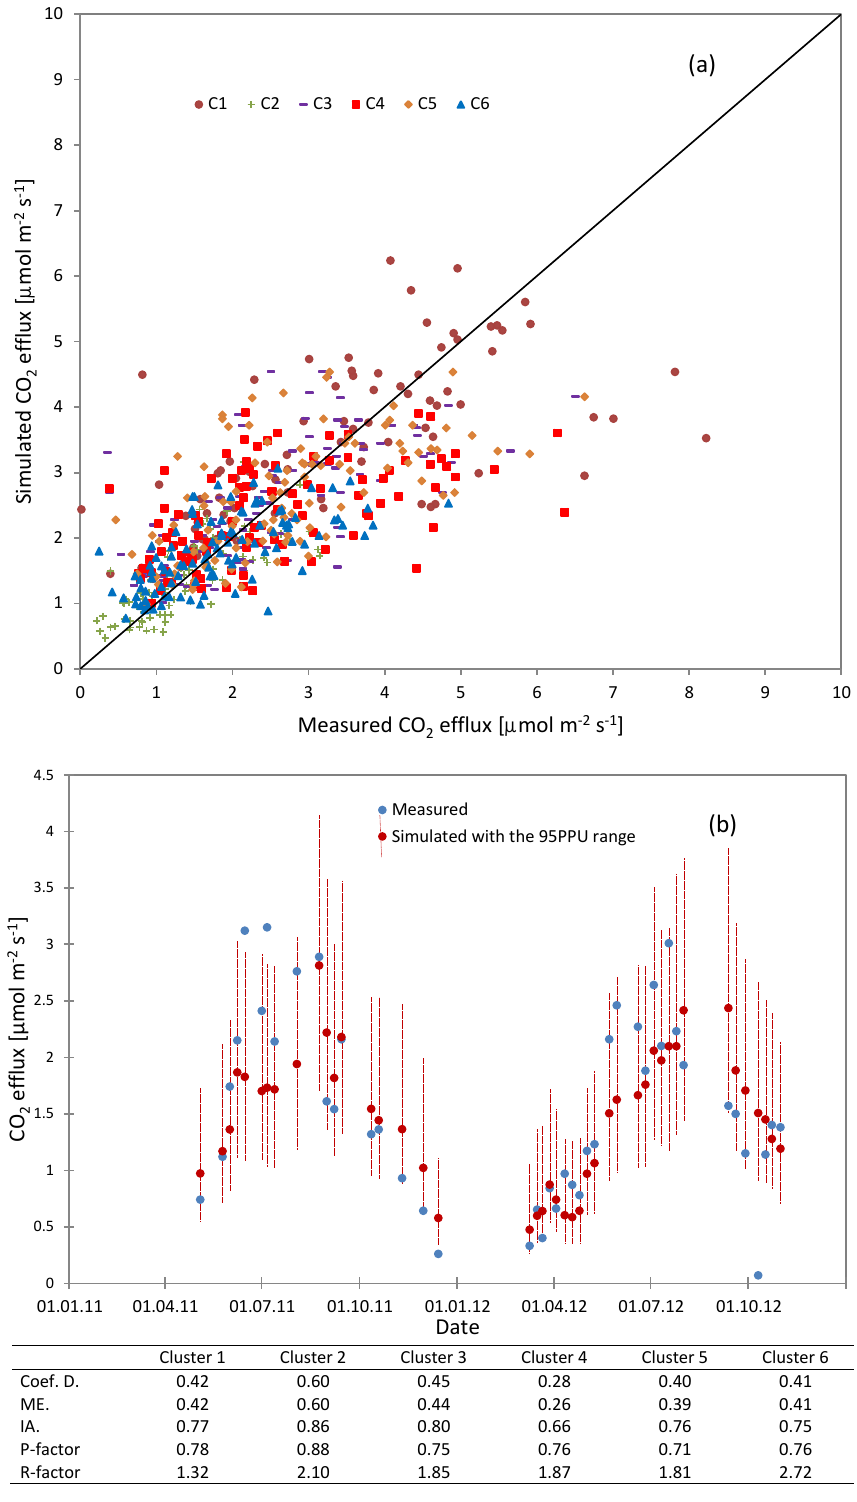
Fig. 5. Simulated vs. observed CO 2 efflux for selected sites from the clusters using HYDRUS-1D. The simulation quality measures are displayed in the associated table. (a): Scatter plot of simulated vs. measured CO 2 efflux for all clusters from 2006 to 2012, (b): Simulated vs. measured CO 2 efflux with associated 95 percent prediction uncertainty (95PPU) from 2011 to 2012 for the site M8 (cluster C2). C1… 6 means clusters 1… 6.